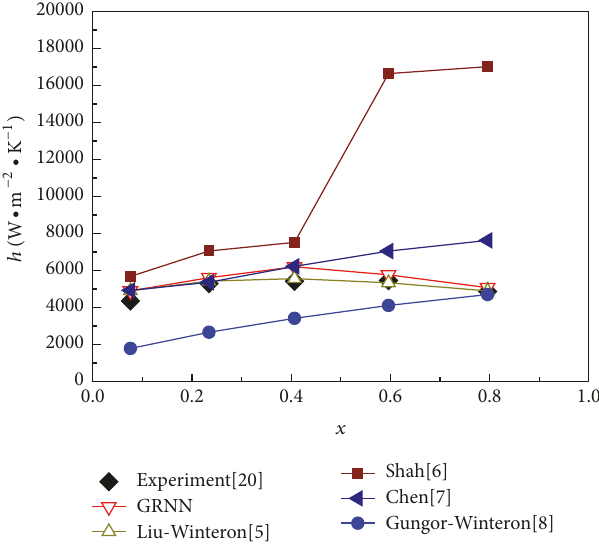
Figure 5: When the evaporation temperature is 40 ∘ C, the heat transfer coefficient of R245fa changes with dryness and mass flux rate.